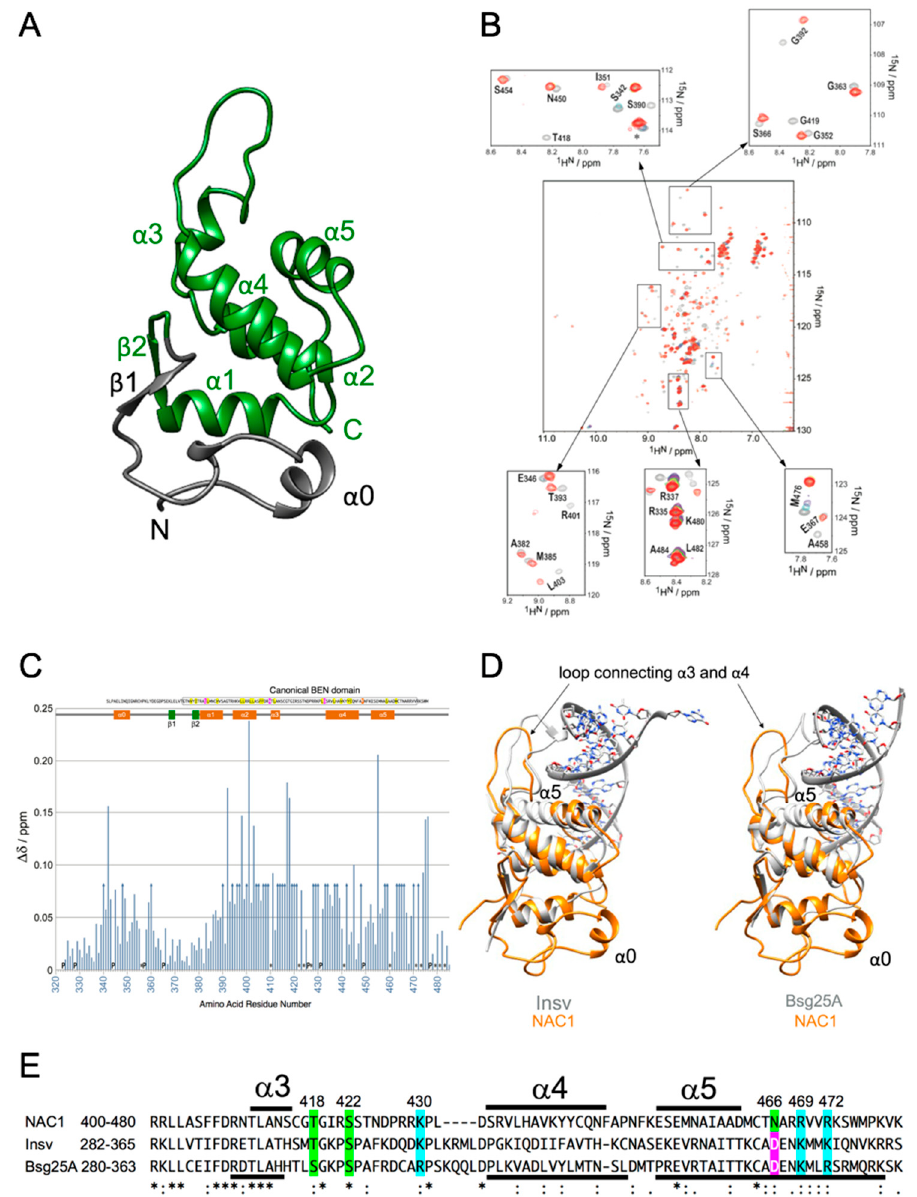
Figure 3. NMR experiments of NAC1. ( A ) Ribbon representation of the lowest-energy solution structure of the BEN domain from human NAC1 (residues 322–485), determined by NMR spectroscopy. The secondary structure elements are shown with arrows ( β -strand) and helices ( α -helix). The predicted BEN domain is colored green. ( B ) NMR titration experiments of NAC1 with the NAC1 consensus dsDNA oligonucleotide. Overlay of the 1H–15N HSQC spectra of NAC1(322-485) alone (grey) and in the presence of 0.2 (purple), 0.4 (cyan), 0.6 (magenta), 0.8 (green), 1.0 (yellow), 1.2 (pink), and 1.5 (red) equivalents of dsDNA oligonucleotide. The five insets show peaks that disappeared or gradually changed position (from grey to red) in selected spectral regions upon the addition of dsDNA oligonucleotide. ( C ) Total changes in 1HN and 15N chemical shifts ( ∆ δ ) for NAC1(322-485) upon the addition of dsDNA oligonucleotide to a ratio of [protein]:[dsDNA] = 1:1.5 are plotted versus residue number. ∆ δ is given by ∆ δ = [( ∆ δ HN)2 + ( ∆ δ N / 6.5)2]1 / 2, where ∆ δ HN and ∆ δ N are the chemical shift di ff erences for 1HN and 15N, respectively. Residues that were not assigned (asterisks) or whose 1H-15N resonances disappeared upon the addition of dsDNA oligonucleotide (arrows) are indicated. “P” indicates proline residues. Highly conserved residues of human BEN domain-containing proteins identified by Clustal Omega alignment are highlighted and shown at the top of the plot. See Figure 1A. The canonical BEN domain is boxed. Color coding reflects the